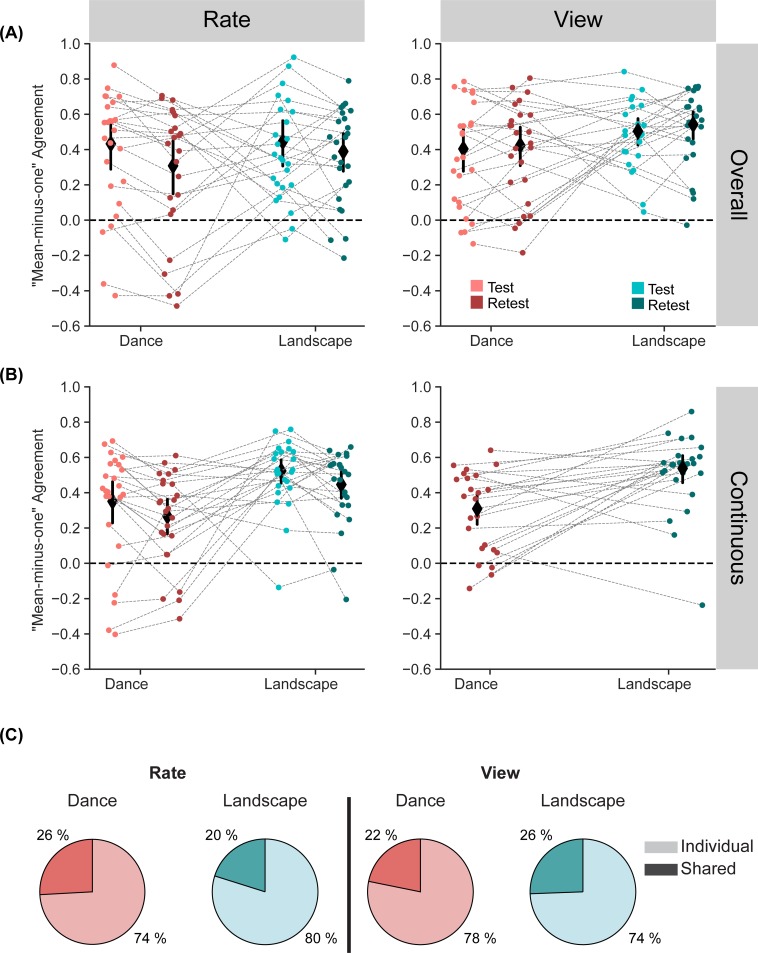
Agreement across participants with “mean-minus-one” (MM1) and variance decomposition.(A) Overall rating agreement with MM1: Rate group’s agreement decreased in the retest session whereas view group did not show this session effect. (B) Continuous rating agreement with MM1: Agreement is higher for landscape videos for both groups and retest session agreement is lower for the rate group. (Error bars show 95% confidence intervals calculated with the z-transformed r values, horizontal dashed line indicated zero) (C) The proportion of repeatable variance that is attributable to individual taste is higher than the proportion of variance that is attributable to shared taste for both categories and groups.